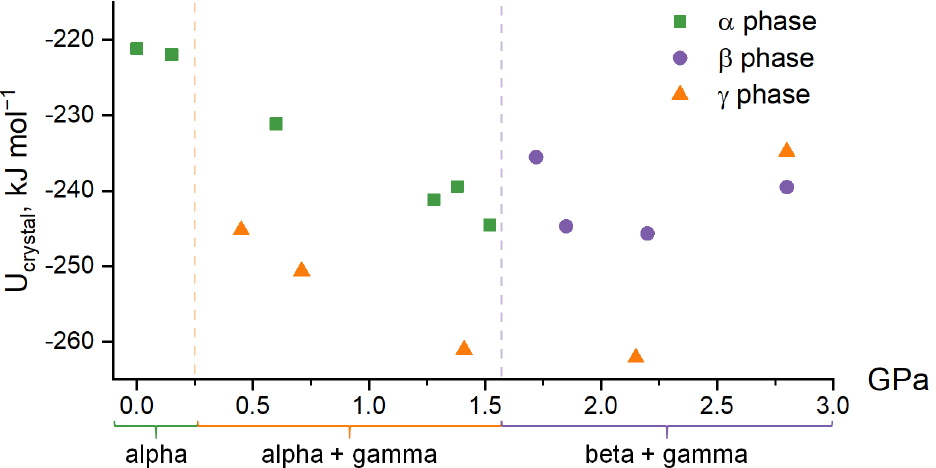
Figure 2. Lattice energies (U crystal = U inter ) of phases α, β, and γ as a function of pressure calculated based on experimental data. Regions of structural stability according to experimental data [18] are shown with dashed lines.